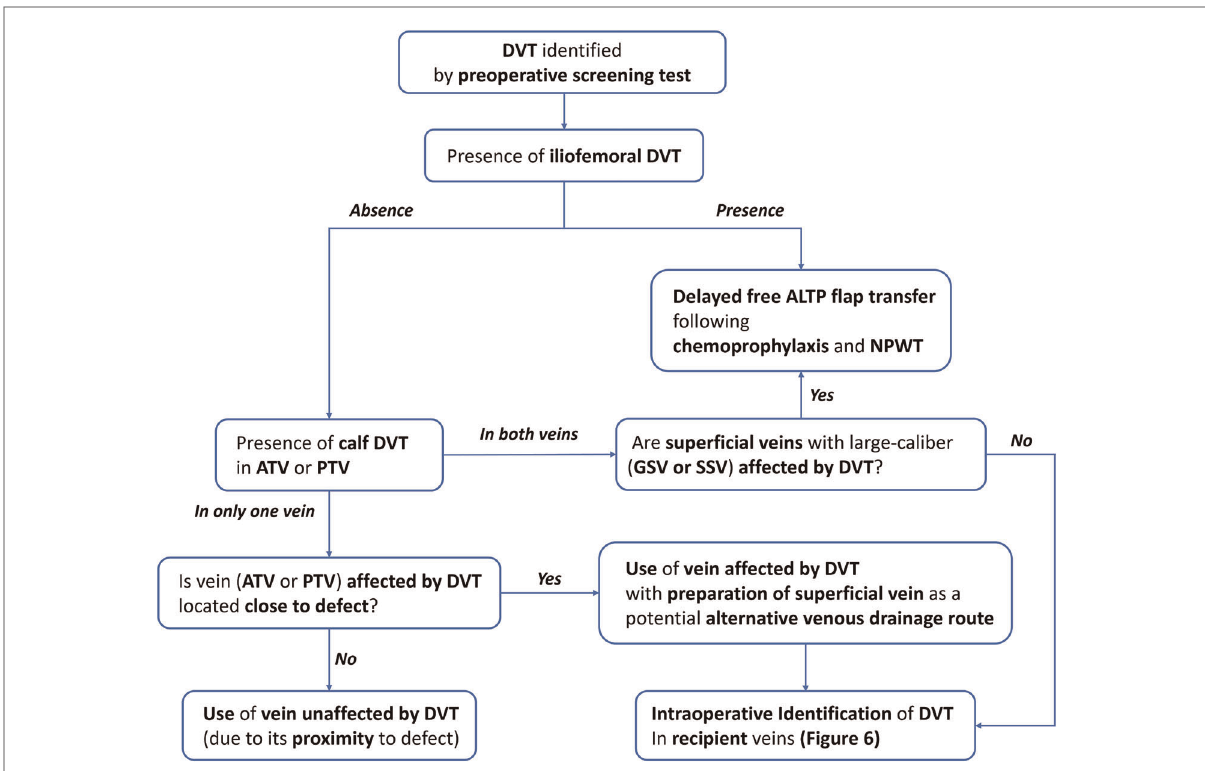
FIGURE 5 An algorithm for lower extremity reconstruction using a free ALTP fl ap in patients with DVT diagnosed by preoperative screening test. DVT, deep vein thrombosis; ATV, anterior tibial vein; PTV, posterior tibial vein; GSV, greater saphenous vein; SSV, small saphenous vein; NPWT, negative pressure wound therapy.